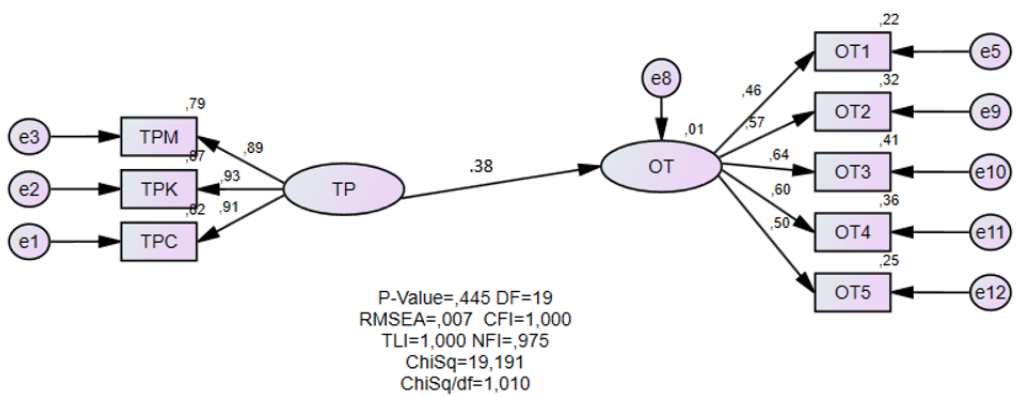
Figure 5: Model of Perception Based on Structural Equation Analysis with Parental